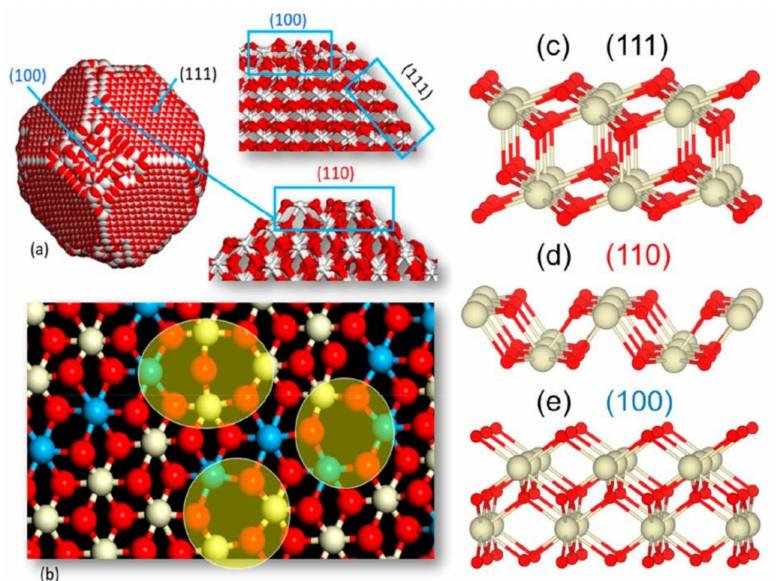
Figure 3. ( a ) Structure of ceria nanoparticle (NP) with (111), (110), and (100) surfaces. ( b ) View of one of the (111) surfaces on reduced nanoceria reveals oxygen vacancies (yellow ovals). The structures of defect-free ( c ) (111), ( d ) (110), and ( e ) (100) surfaces. Ce (IV) is white, Ce (III) is blue, and oxygen is red. Reprinted with permission from [29], Copyright © 2021, American Chemical Society.